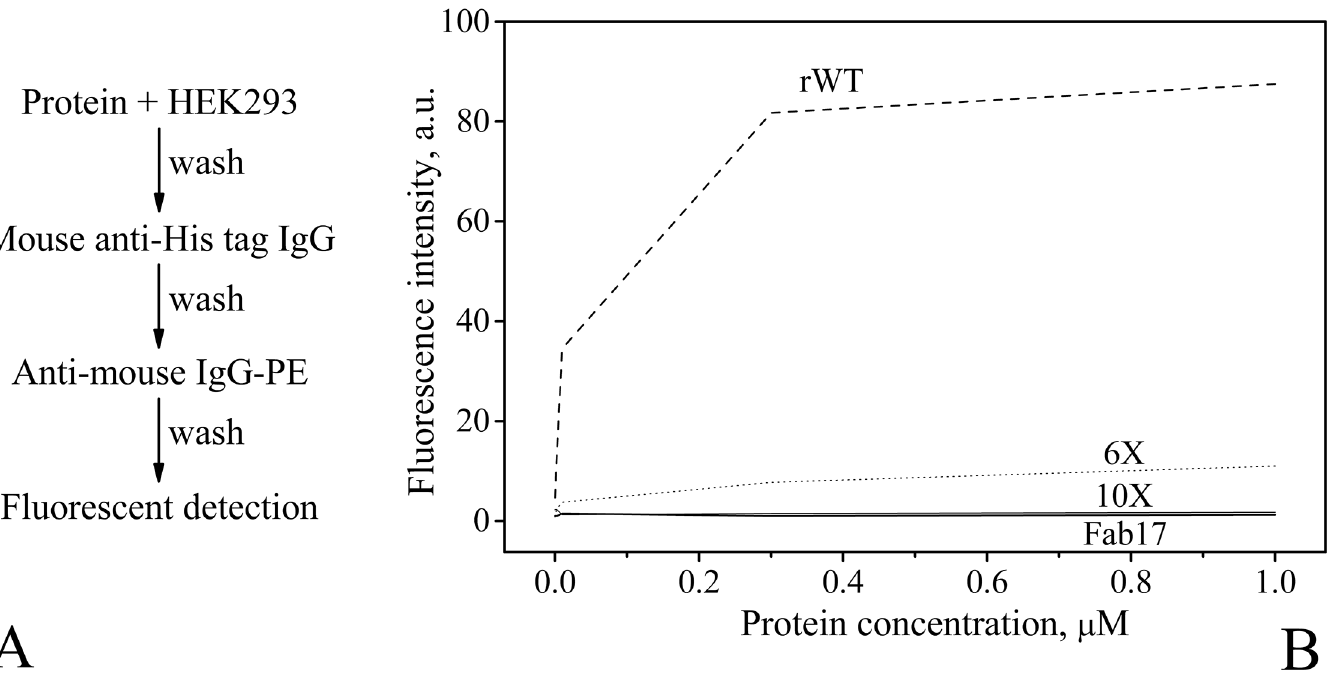
Fig 4. The scheme of preparation of HEK293 cells for flow cytometry experiment (A) and flow cytometry data for the HEK293 cells versus protein concentration (B). HEK293 cells were incubated with 6×His-tagged L35Ae or anti-hCCR7 Fab17 used as a negative control, followed by immunostaining. FACS buffer contained PBS, 150 mM NaCl, pH 7.0, 1 – 1.5% calf serum, and 0.01% NaN 3 . R-Phycoerythrin (PE) fluorescence was excited at 532 nm and detected at 580 – 583 nm.